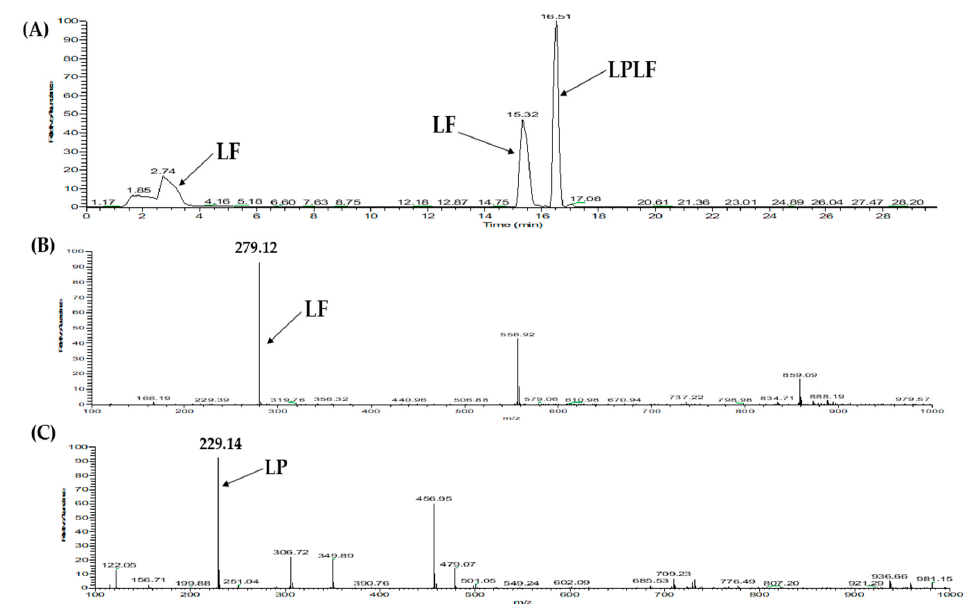
Figure A2. ( A ) LC-MS profile of LPLF pre-incubated with DPP-IV at 37 °C for 3 h. ( B ) MS spectrum of fragment LF ( m / z 279.12), and ( C ) MS spectrum of fragment LP ( m / z 229.14) derived from LPLF pre-incubated with DPP-IV at 37 °C for 3 h.